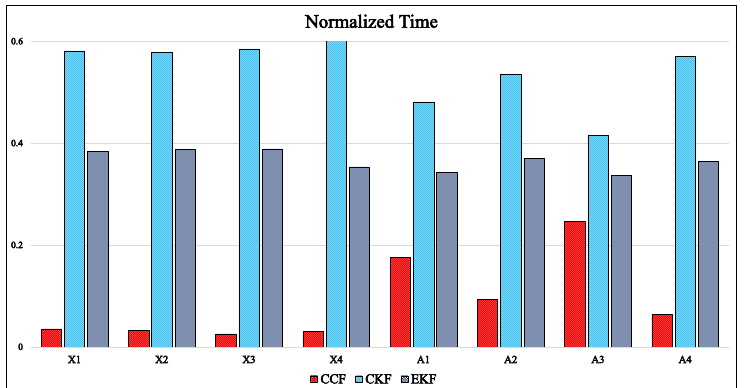
Figure 11. Comparison of proposed CCF structure with other estimation algorithms on Ar- ducopter datasets.